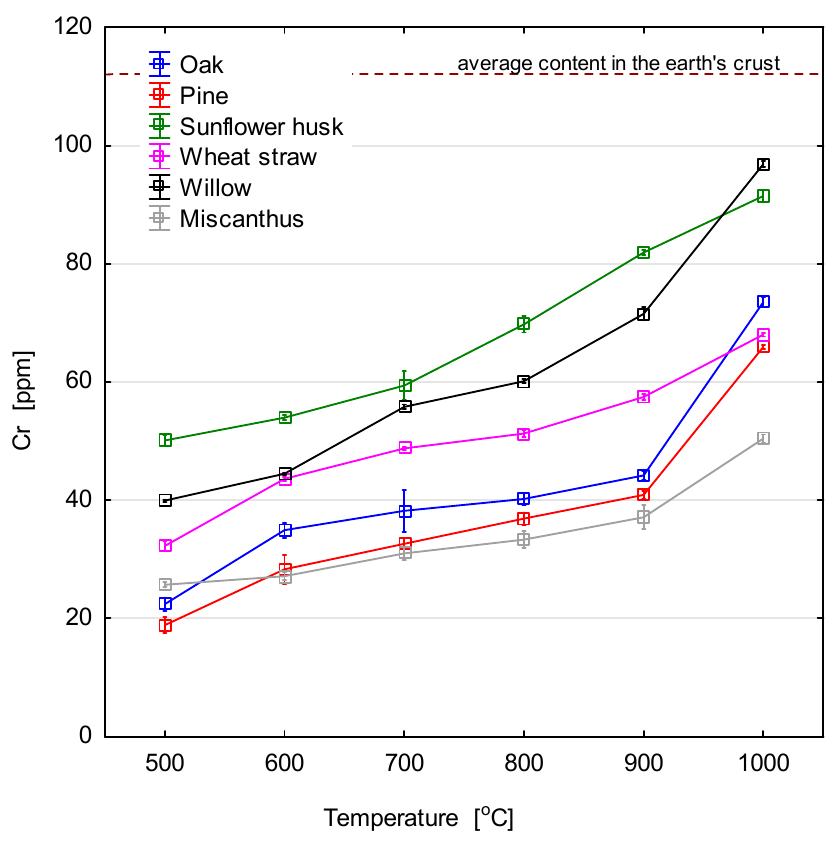
Temperature [ o C] Figure 2. Changes in Cr content in the examined biomass depending on ash-forming temperature.